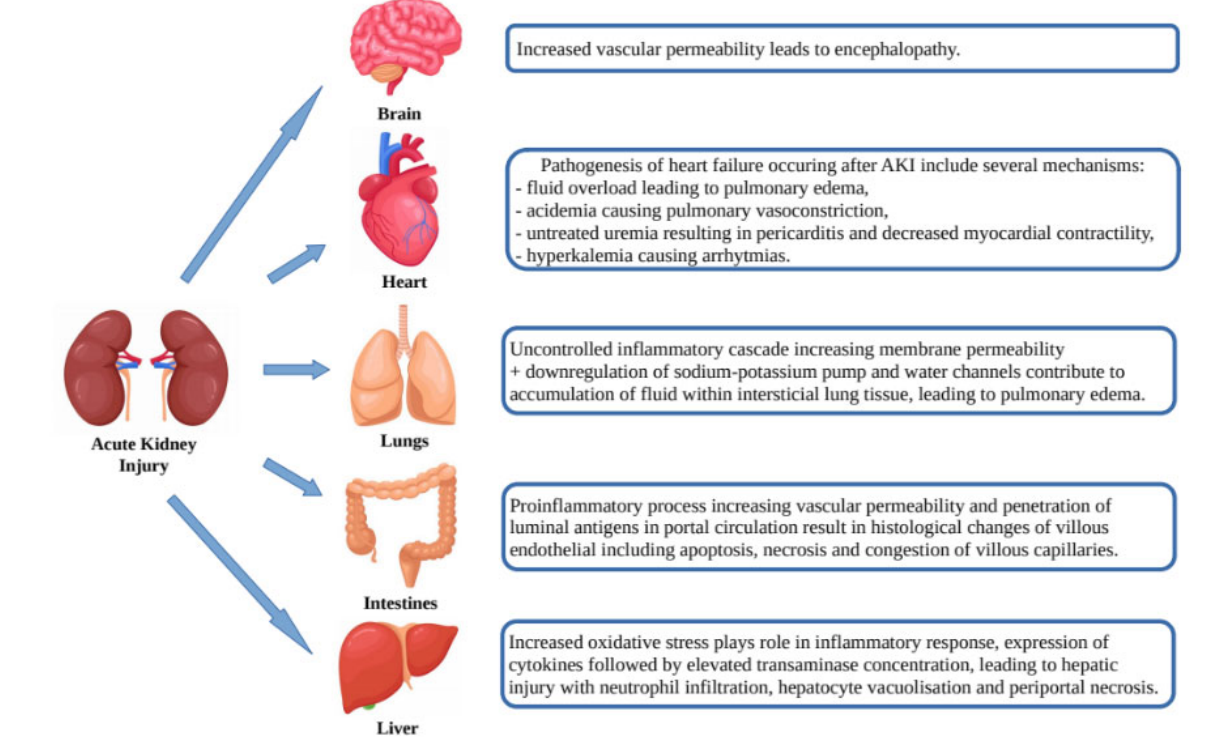
Figure 2. Effects of acute kidney injury on organ dysfunction.